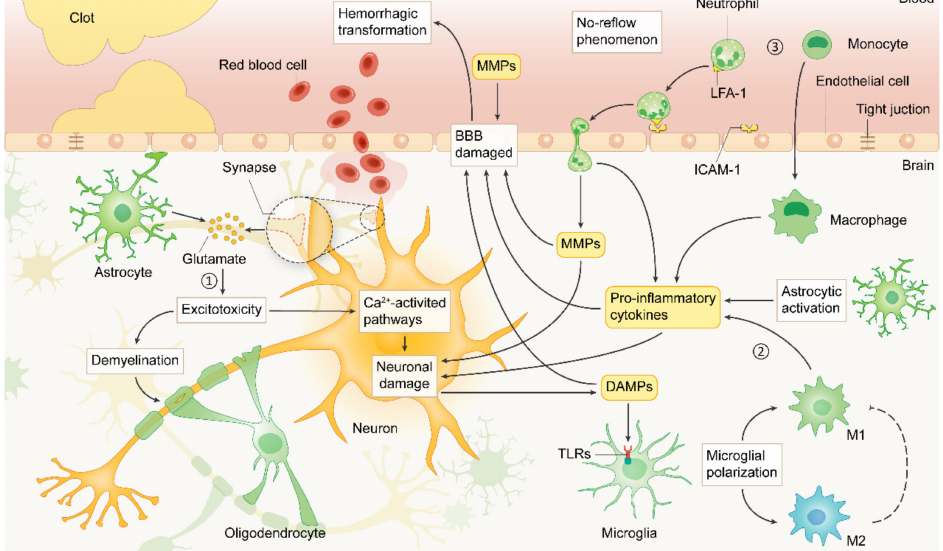
Figure 1. Ischemic cascade response in the acute phase after stroke. Once blood flow is disrupted, neuronal cells and astrocytes release large amounts of glutamate, resulting in excitotoxicity ( 1 ) and prompting cell death. The dead cells release damage-associated molecular patterns (DAMPs), which further stimulate microglia polarization, astrocyte activation, and release of pro-inflammatory factors ( 2 ). Blood-derived neutrophils and macrophages migrate to the injured area ( 3 ), further amplifying the ischemic cascade response. MMPs, matrix metalloproteinases; LFA-1, lymphocyte function-associated antigen-1; ICAM-1, intercellular adhesion molecule-1; BBB, blood-brain barrier; M1, M1 phenotype microglia; M2, M2 phenotype